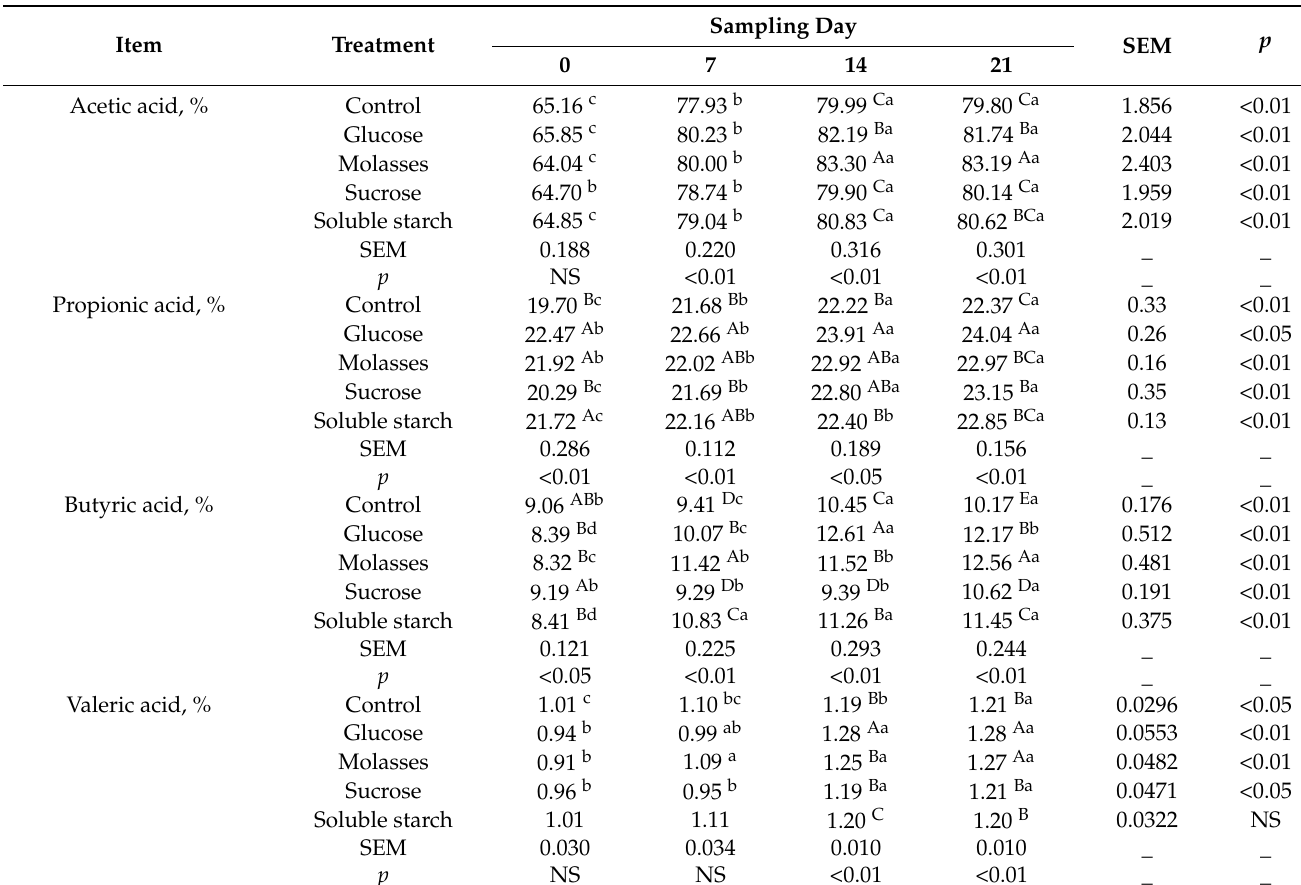
Table 8. Proportion of volatile acids in rice